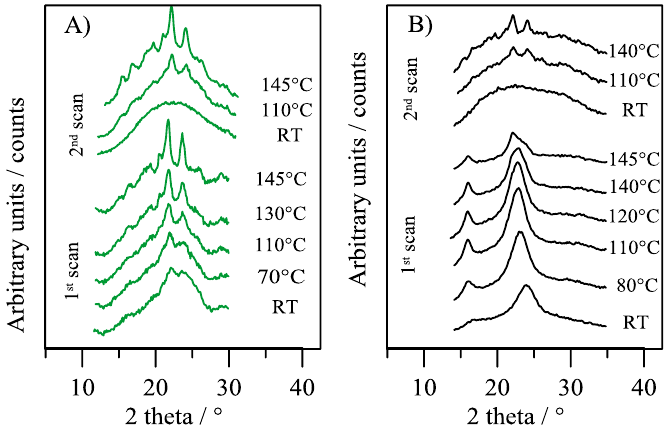
Figure 4. In situ XRD patterns collected at different temperatures (I scan and II scan after quenching from the melt) for PBTF film ( A ) and stretched film ( B ).